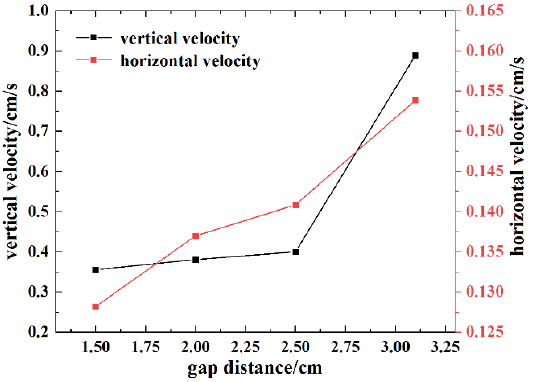
Figure 14. The horizontal and vertical speed of the flame propagation with different gap distances.